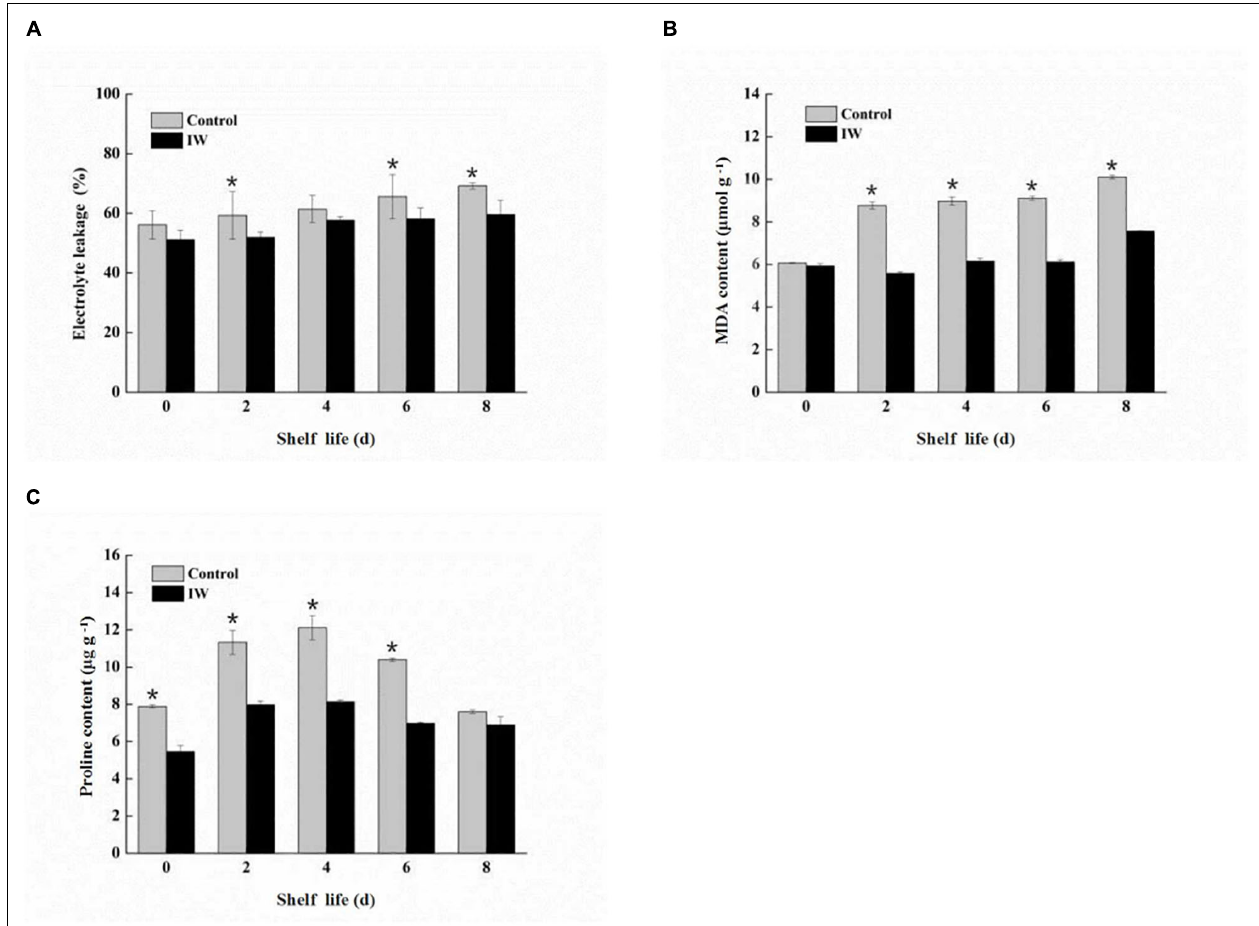
FIGURE 2 | Effect of intermittent warming on electrolyte leakage (A) , MDA content (B) , and proline content (C) of blueberry fruit during shelf life at room temperature after 30 days refrigeration. Mean ± SE of three replicate experiments are shown. Asterisks indicate significant differences between control and IW-treated fruit (* p <